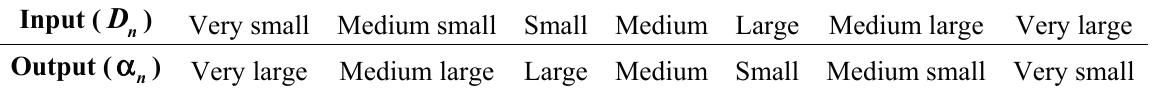
Figure 4. ( a ) The membership function of input; ( b ) The membership function of output. Table 4. The fuzzy if-then rules of